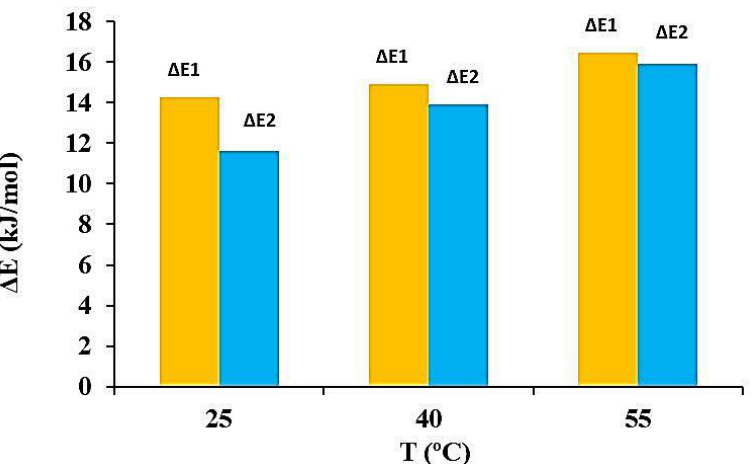
Figure 8. The behavior of energetic parameters as a function of temperature for MB adsorption. by BE/SD – MNPs composite.